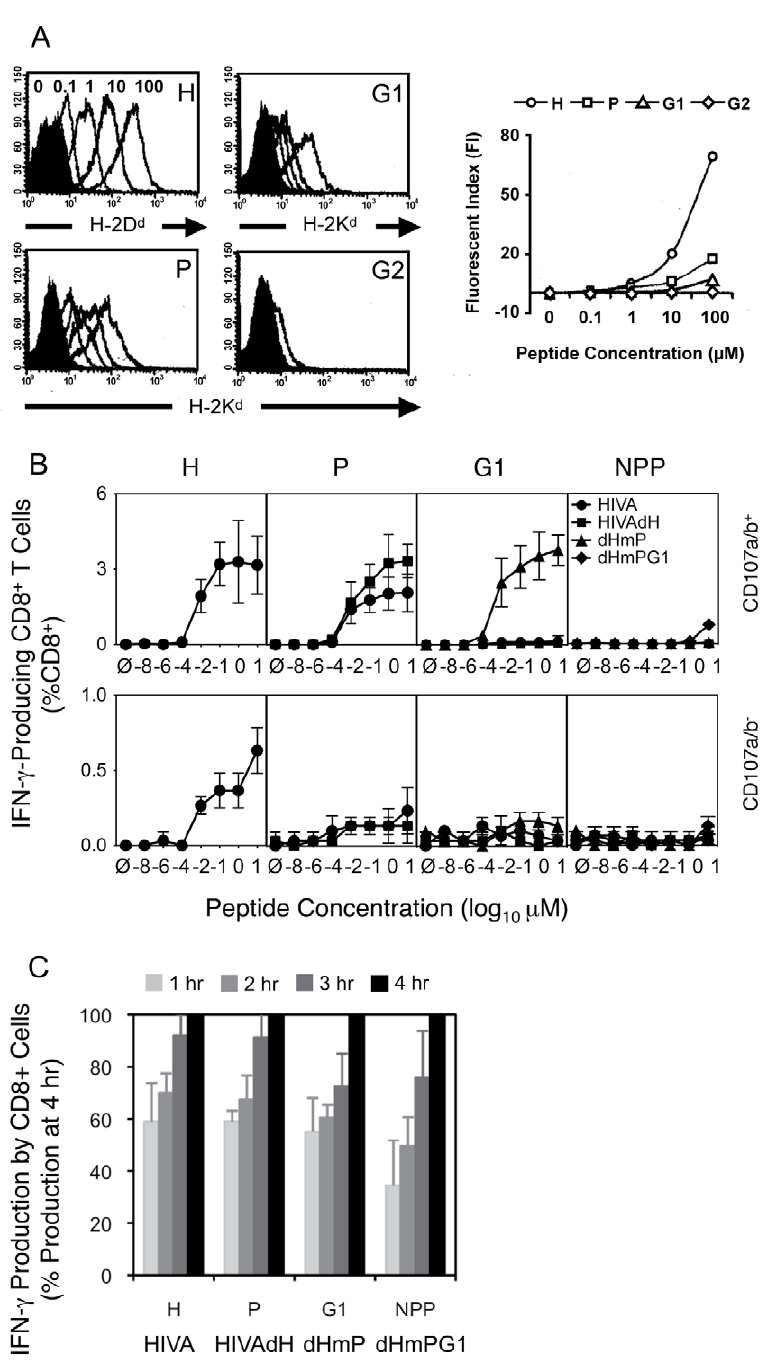
Figure 3. Contributing mechanisms of immunodominance. A) Binding affinities of peptides H, P, G1 and G2 (as indicated in the top right corners) to their respective MHC class I complexes stably transfected into TAP-deficient T2 cell lines were assessed. T2 cell lines were incubated with decreasing peptide concentrations ranging from 100 m M to 0.1 m M indicated above the H peptide histogram and the cell surface peptide-loaded MHC complexes were detected by fluorochrome-conjugated mAb (DB Biosciences) and quantified using FACS flow cytometer. B) and C) Groups of 3 BALB/c mice were given 3x immunizations using 100 m g of DNA expressing the index or mutated forms of HIVA at 3 wk intervals and their T cell responses were analyzed 4 wk later. B) Splenocytes were assessed in an ICS assay using peptides indicated above the graphs at concentrations ranging from 10 to 10 2 8 m M for 5 h. Cells were gated on IFN- c -producing CD8 + T cell populations positive (top) or negative (bottom) for CD107a/b. Note the different y-axis scales on the top and bottom graphs. C) The response kinetics of CD8 + T cells re-stimulated with 0.1 m M peptides was assessed in an ICS assay in 1-h intervals for a period of 4 h. Data shown are as mean 6 SD of [CD8 + CD107a/b + IFN- c + cells at each time point (%)] 4 [CD8 + CD107a/b + IFN- c + at 4 h (%)]. One out of two independent experiments is shown.